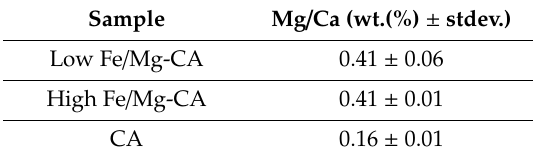
Table 4. Comparison of the amount of Mg 2 + substitutes for Ca 2 + in low and high Fe / Mg-CA NPs.